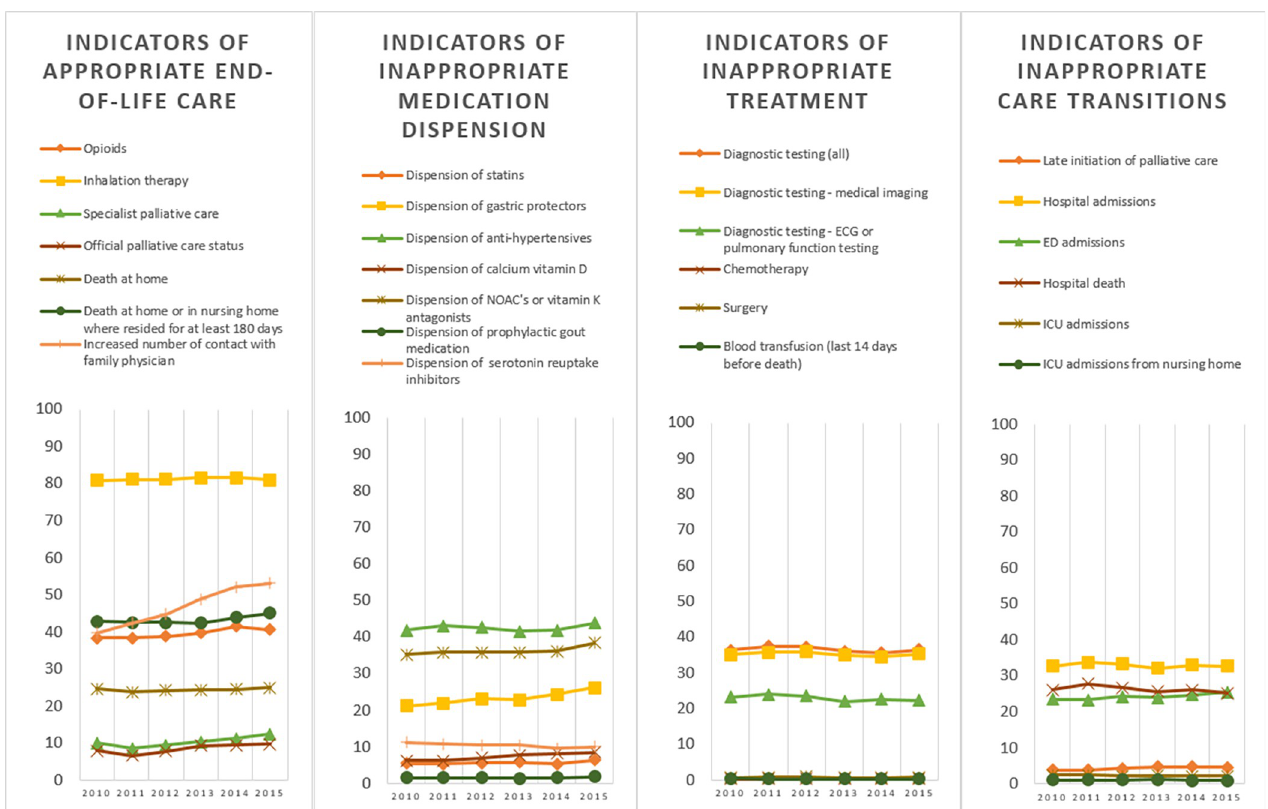
Fig 3. Trends in indicators of appropriate or inappropriate care in the last 30 days of life for people for people dying with dementia, thematically grouped. The Y-axis represents the risk adjusted percentage of the population that received the treatment or care specified for this quality indicator.